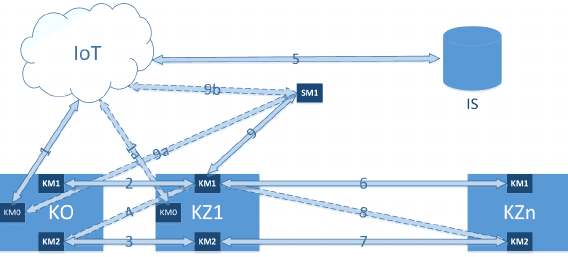
Figure 4: Block diagram of smart train